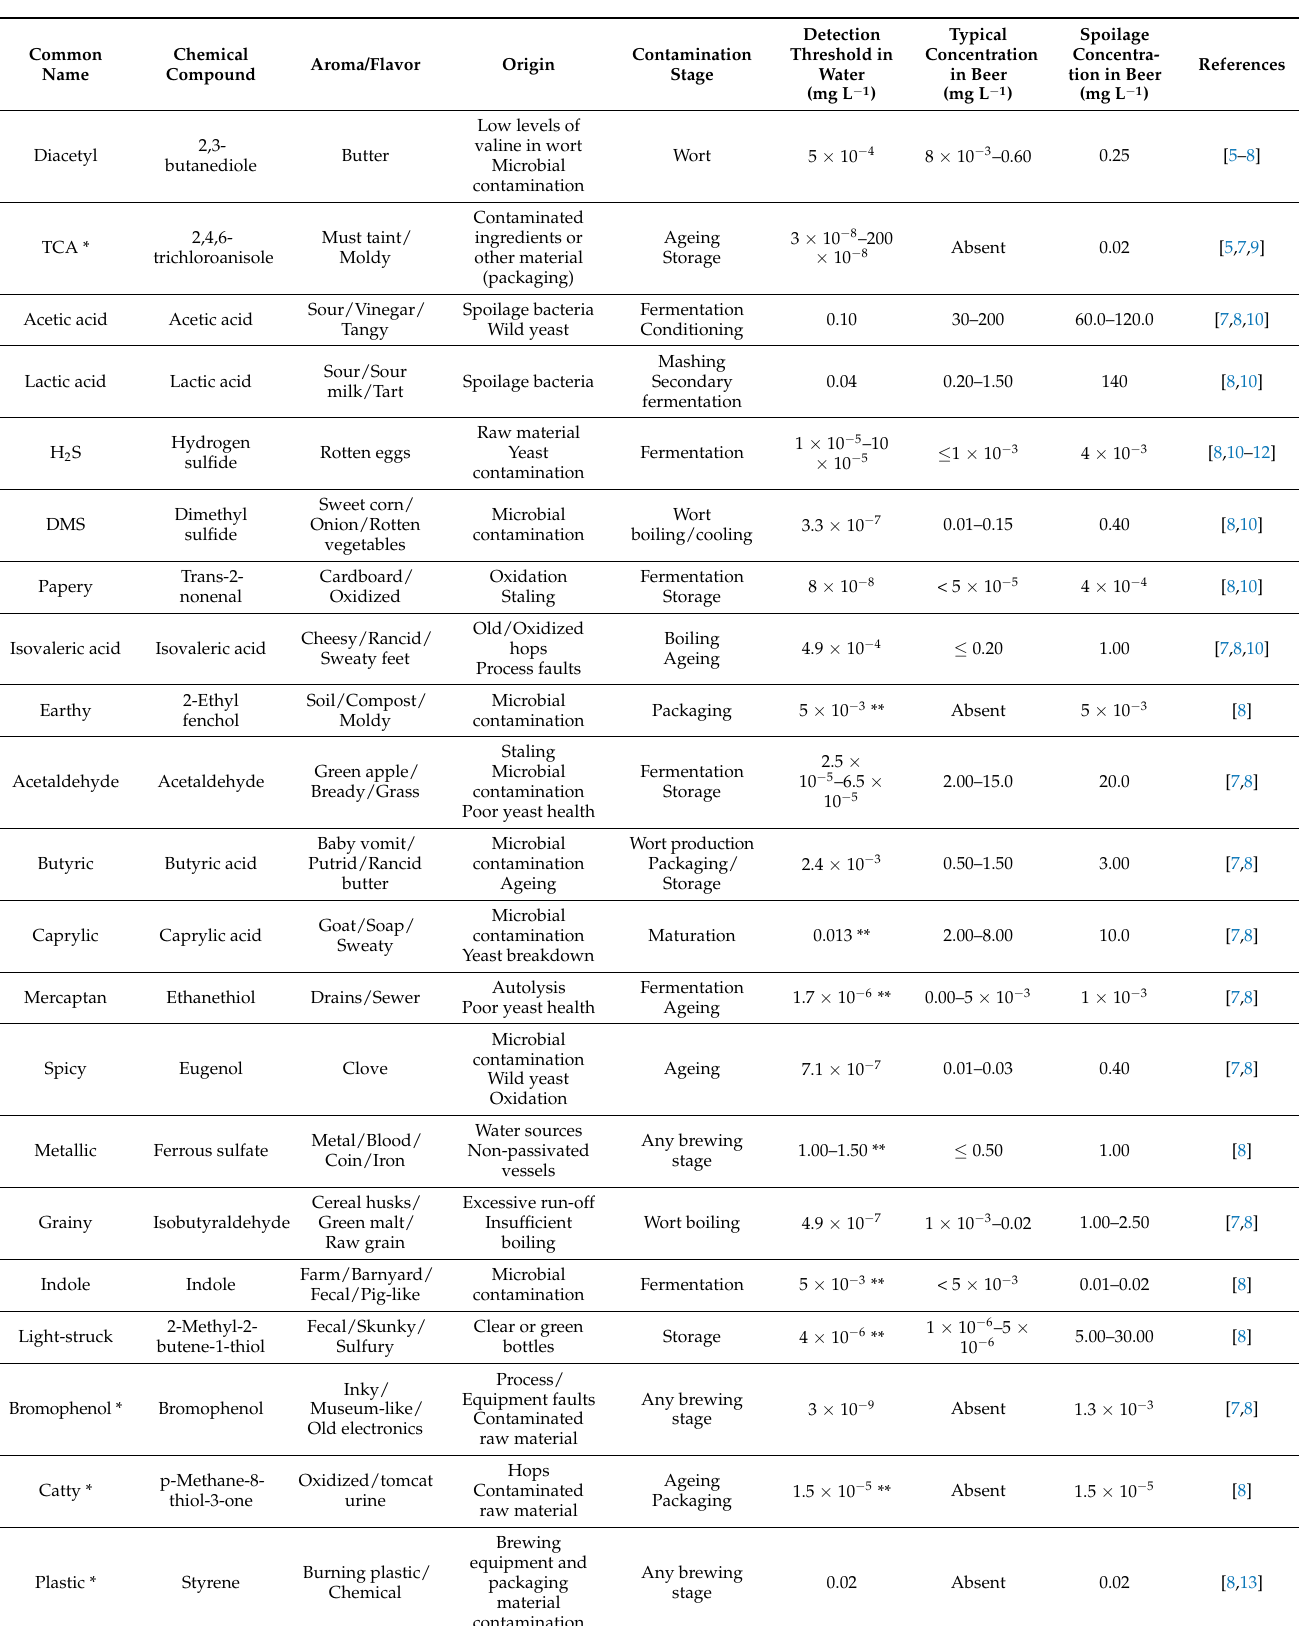
Table 1. Description and concentrations of typical beer faults